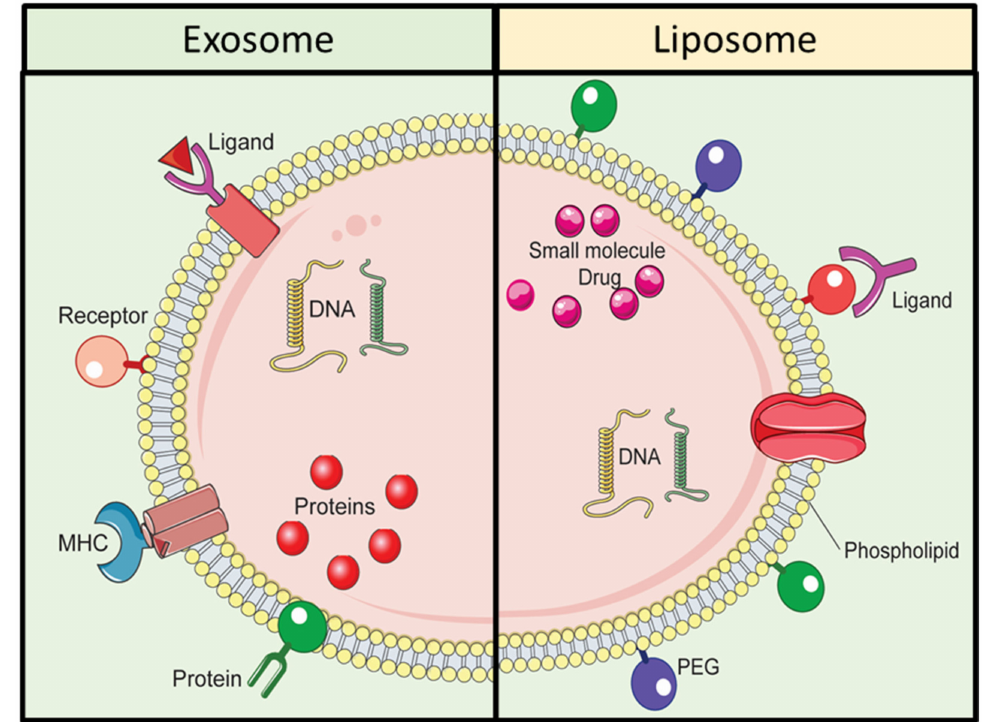
Figure 3. Comparative schematic illustration of exosomes and